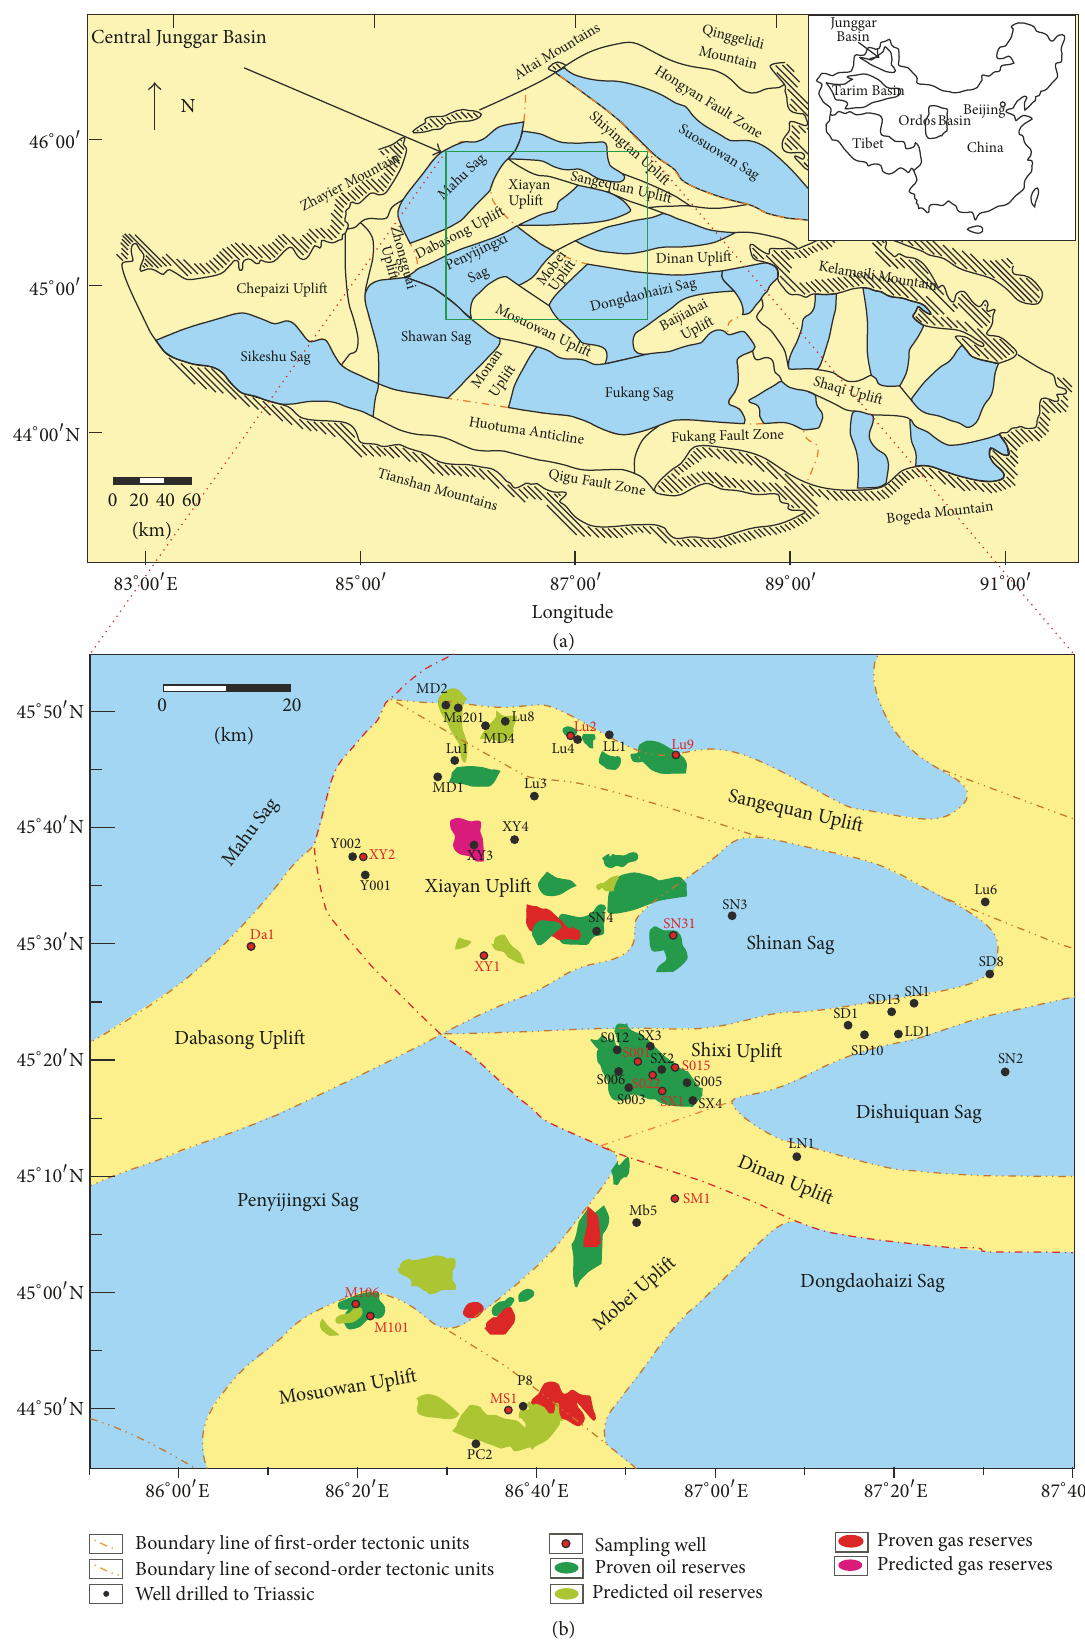
Figure 1: (a) Structural units of the Junggar Basin and (b) structural units and key wells of the studied central